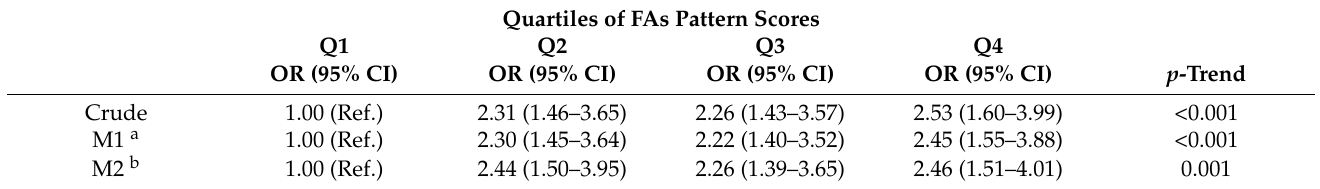
Table 5. Multivariable associations of plasma fatty acids pattern scores across quartiles and the presence of dry eye disease in the Montrachet